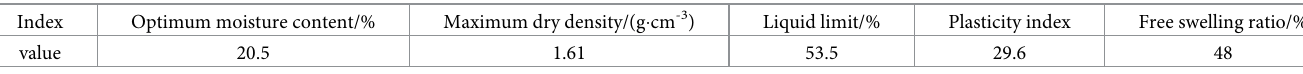
Table 1. Basic physical parameters of the test soil.